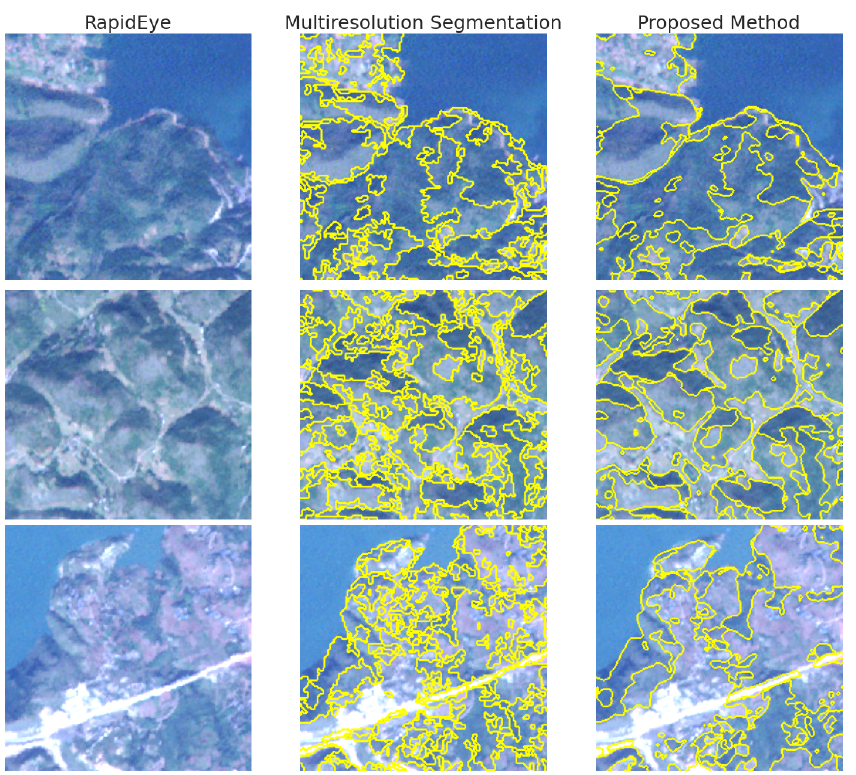
Figure 12. Segmentation results of multiresolution segmentation method and the proposed method.